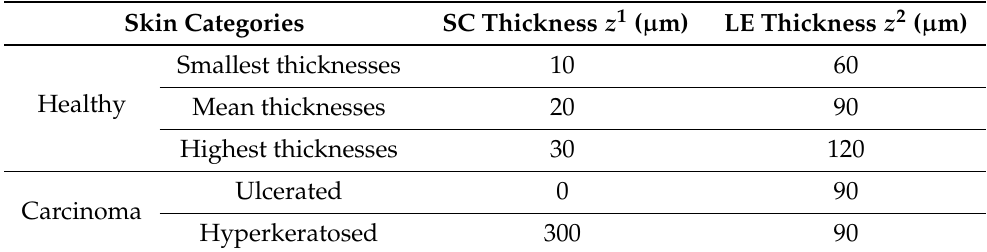
Table 2. Values of the SC (stratum corneum) and LE (living epidermis) layer thicknesses implemented in our skin model to simulate five different healthy skin and carcinoma